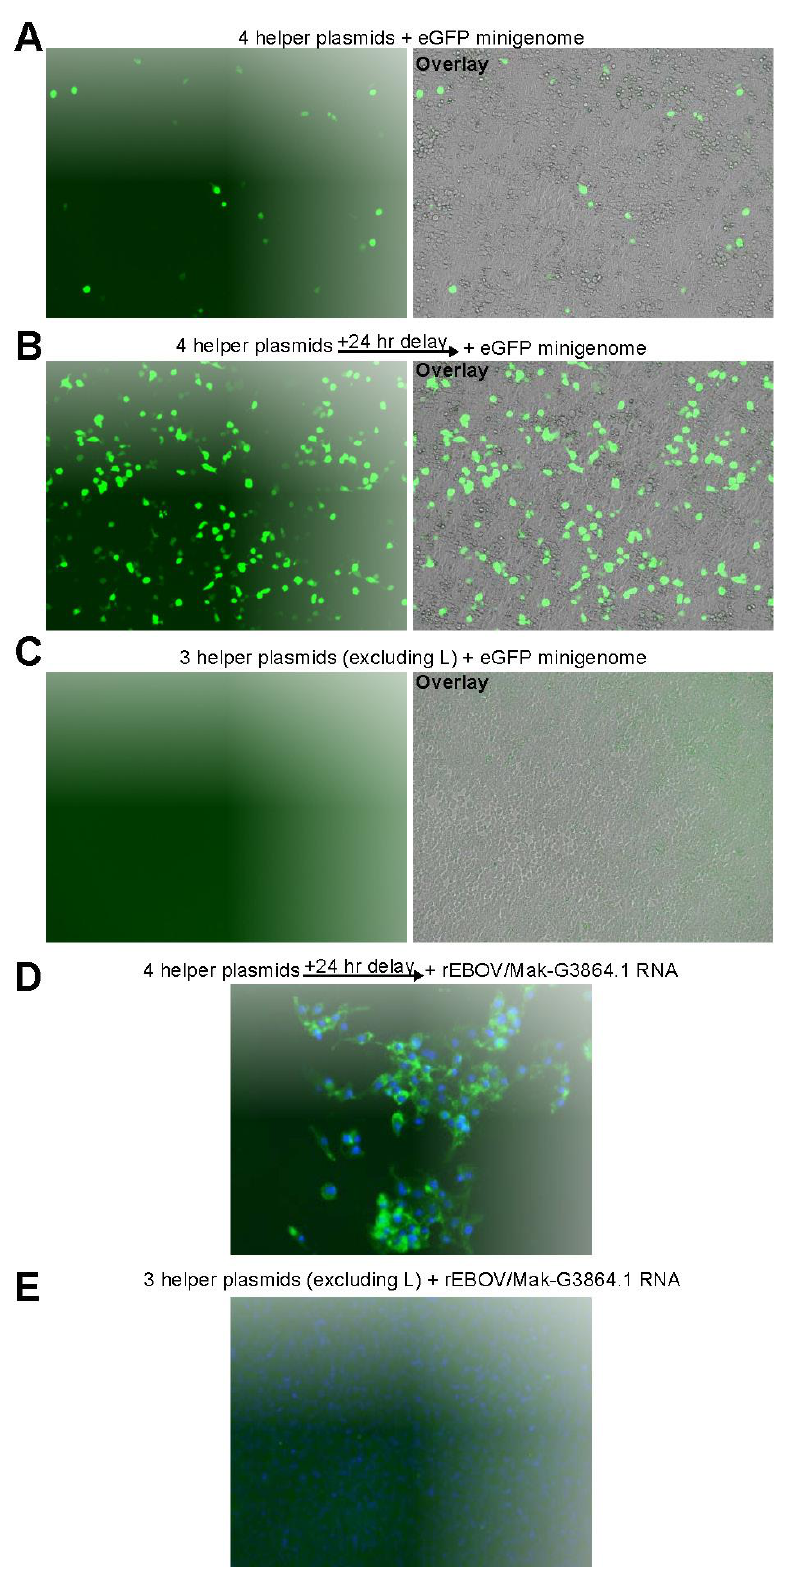
Figure 3. EBOV/Mak-G3864.1 minigenome and virus rescues. HEK 293T cells were transfected with expression plasmids having codon-optimized open reading frames encoding the EBOV/Mak- G3864.1 helper proteins NP, VP35, VP30, and L. eGFP expression was examined 48 h after helper plasmid transfections. ( A ) In addition to helper protein-encoding plasmids, a plasmid expressing T7 RNA polymerase and a minigenome plasmid encoding eGFP, flanked by the EBOV/Mak-G3864.1